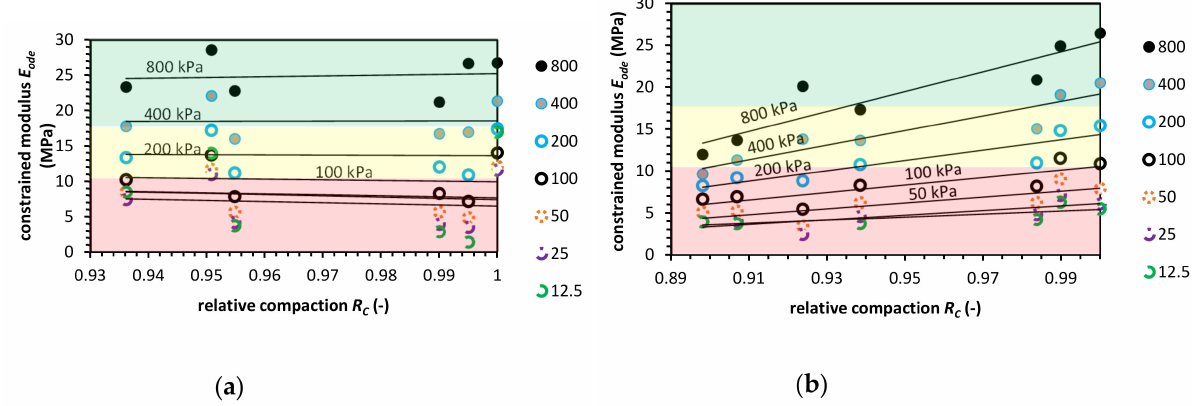
Figure 6. Constrained modulus value versus relative compaction value for recycled asphalt pavement (RAP) for ( a ) the Proctor compaction and ( b ) the Vibro compaction method. Colored areas mean required constrained modulus value, colors indication: green-zone of fulfilled E ode modulus requirement; yellow-moderate zone, where the constrained modulus is in the range of requirements; red-zone in which the E ode do not meet pipe fill